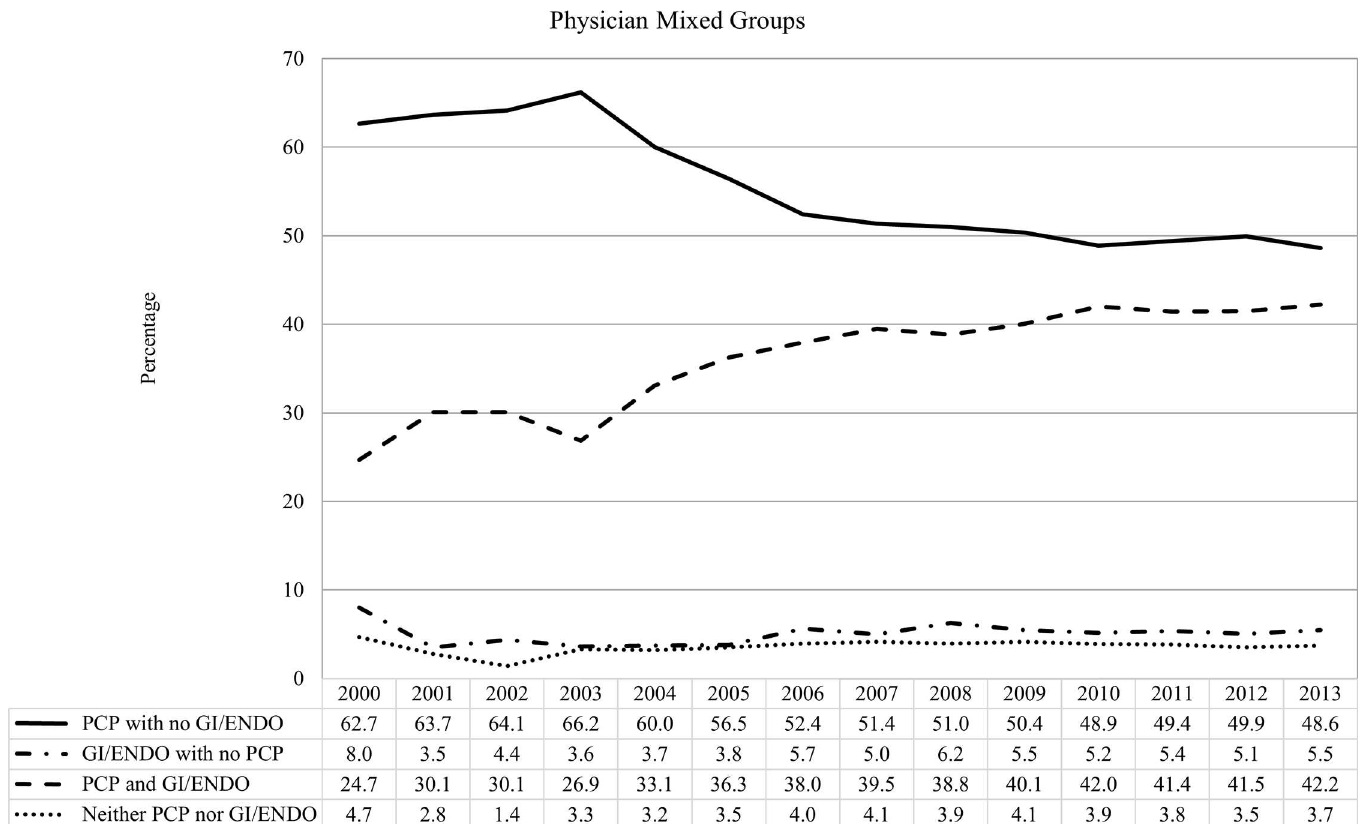
Fig 2. Distribution of physician mix categories among dually diagnosed